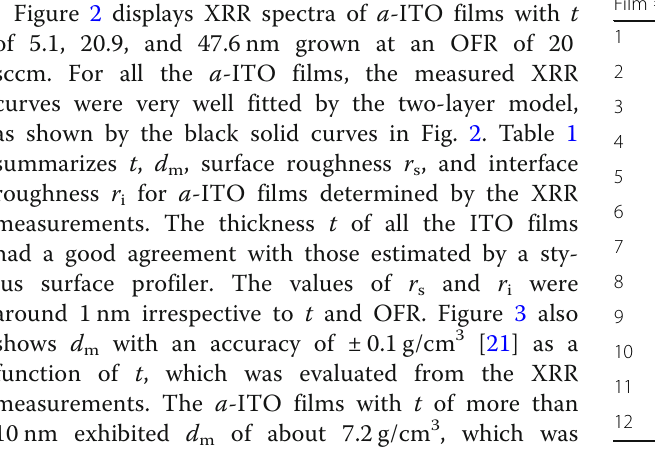
almost the same as that of bulk ITO [12]. The d a -ITO films with t below 7 nm decreased abruptly with decreasing t regardless of the OFR; the d values of 5-nm-thick a -ITO films with OFRs of 20 and 30 sccm were 6.6 and 6.8 g/cm 3 , respectively.